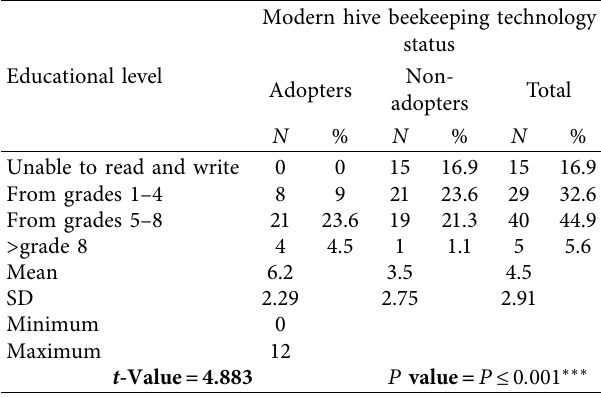
Table 4: Age of the household head.